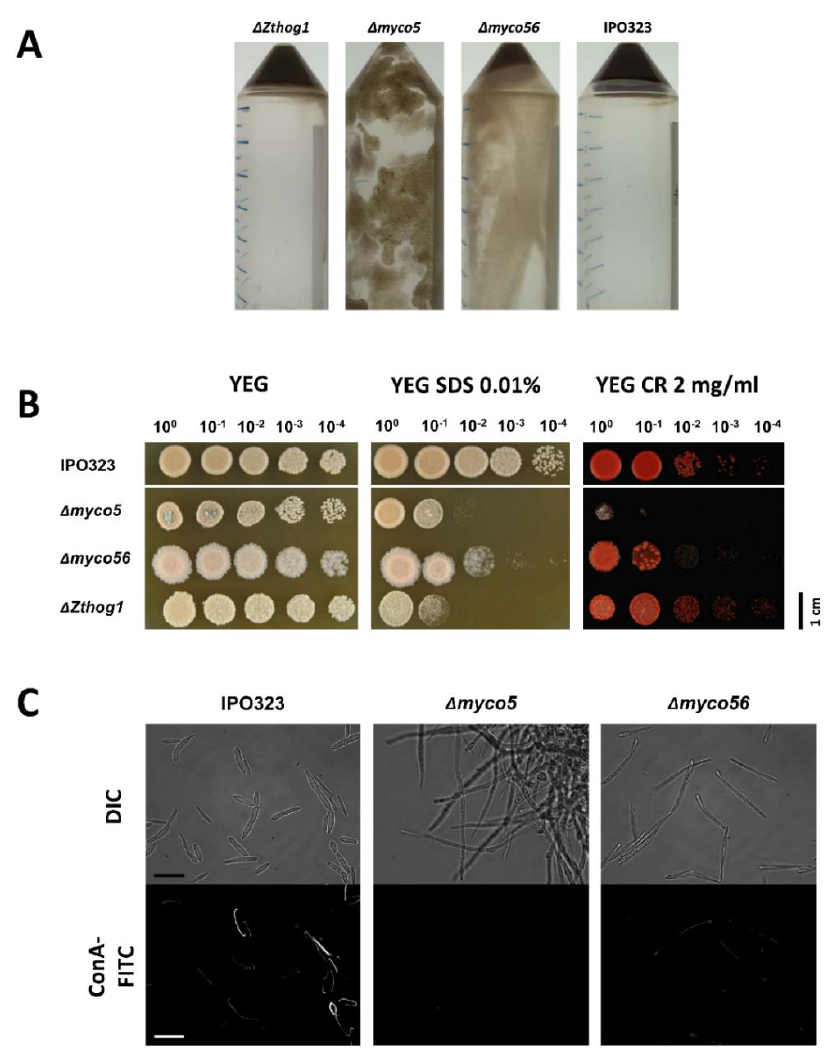
Figure 11. Involvement of MYCO5 and MYCO56 in cell-wall-integrity maintenance. ( A ) Pellet stability analysis was carried out by centrifugation at 4000 rpm of the strains cultured in YEG fluid medium for 4 days at 18 °C. After centrifugation, all pellets were directly documented. ( B ) Sensitivity of the mutant strains to cell-wall-perturbing agents. strains were grown on YEG medium with 0.01% SDS or 2 mg/mL Congo Red (CR) for 7 days at 18 °C. Four spots of 1.5 microliter of 1 × 10 8 spores/mL spore suspension were inoculated on the plate. ( C ) Investigation of mutant strain’s cell wall toward the Concanavalin-A (ConA-FITC), using fluorescent microscopy. ∆ myco5 and ∆ myco56 showed altered staining compared to IPO323 both in the number of cells which bound ConA-FITC and the intensity of fluorescent signal. Scale bar = 20 μm.